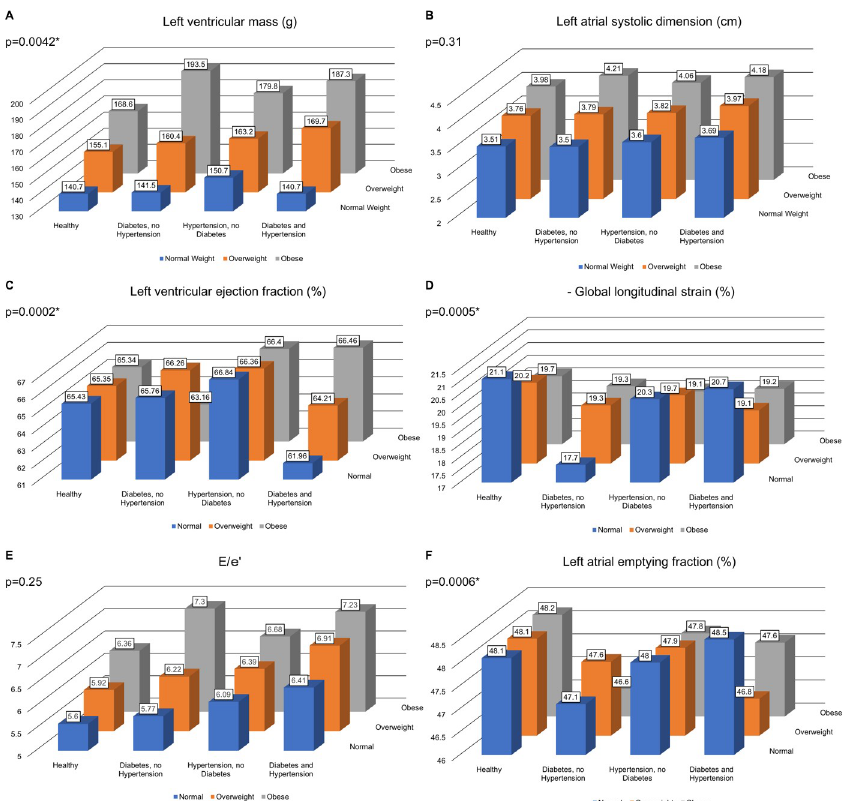
Fig 2. Means of echocardiographic measures. Least squares means of left ventricular mass (A), left atrial systolic dimension (B), left ventricular ejection fraction (C), negative global longitudinal strain (D), E/e’ (E), and left atrial emptying fraction (F) according to cross-classified body mass index (normal weight: BMI < 25kg/m 2 , overweight: 25kg/m 2 � BMI < 30kg/m 2 , obese: BMI � 30kg/m 2) ) hypertension, and diabetes status categories. All models are adjusted for cohort, age and sex. P values correspond to 3-way